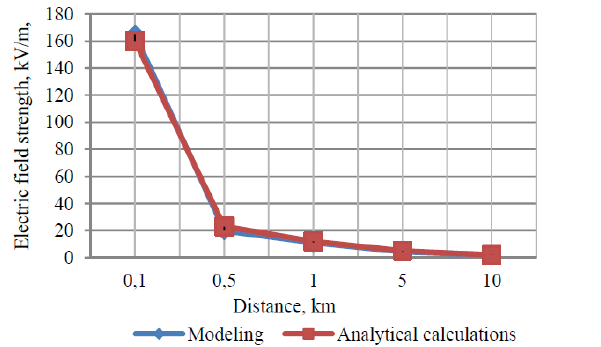
Figure 14. Electric field strength due to lightning.